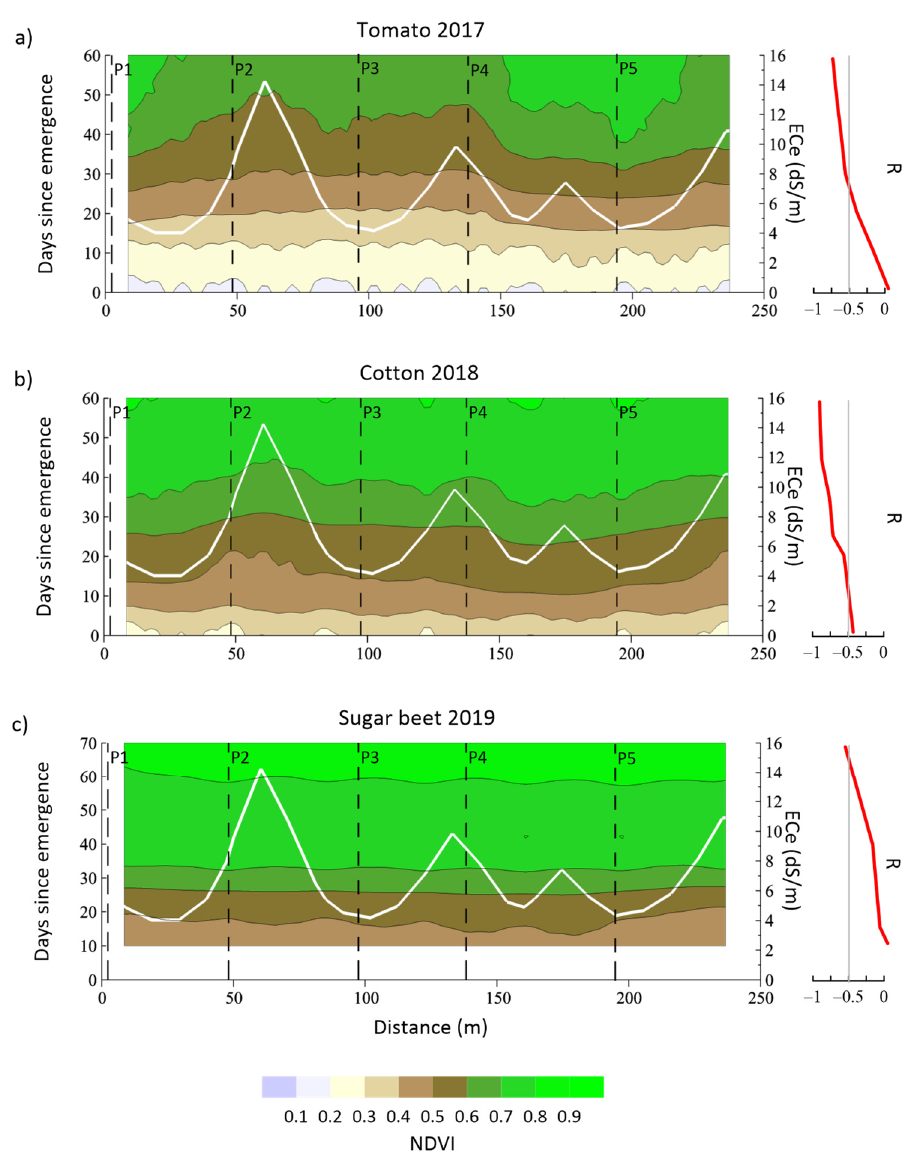
Figure 12. Evolution of NDVI along the transect for ( a ) processing tomato; ( b ) cotton; and ( c ) sugar beet from the day of seedling emergence/transplanting to the day with maximum NDVI. The white and red lines represent estimated ECe at 0.9 m depth in 2017 and its correlation (R) with NDVI, respectively.